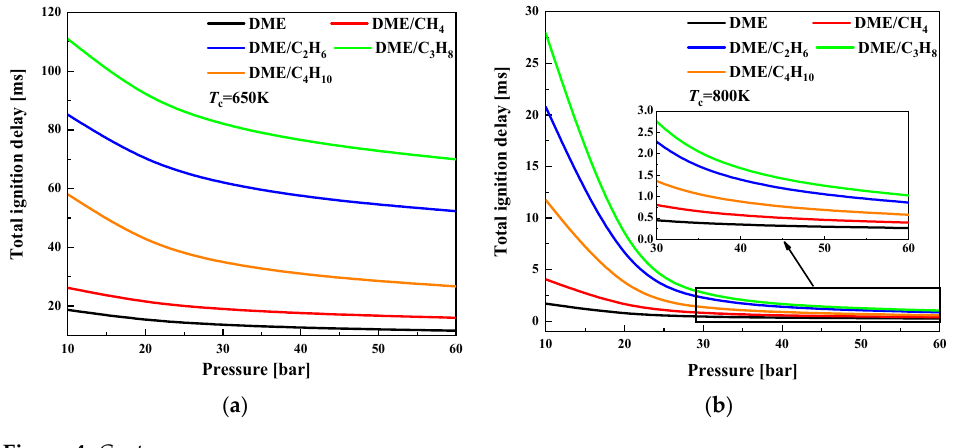
( c ) Figure 4. Ignition delay as a function of compressed pressures for various compressed temperatures at φ = 0.5: ( a ) T c = 650 K; ( b ) T c = 800 K; and ( c ) T c = 1500 K. 3.1.3. Mole Fraction Analysis To clarify the interaction mechanism between DME and C1-C4 alkane during the ig- nition process, the mole fraction of certain important species is performed at P c = 20 bar, φ = 0.5, and T c = 650, 800, and 1500 K. Moreover, the free radicals such as H, O, OH, HO 2 , H 2 O 2 , R, and RO 2 play an important role during the ignition process; thus, these free rad- icals are used to represent the ignition chemistry of the mixtures. In order to better compare the mole fraction profile of DME/C1-C4 alkane mixtures, it is essential to use the log-log coordinate in Figures 5–7. Figure 5 show the mole fraction as a function of time at P c = 20 bar, φ = 0.5, and T c = 650 K. As presented in Figure 5, the addition of C1-C4 alkane to DME will decrease the mole fraction of H, O, OH, HO 2 , R, and RO 2 radicals and delay the time corresponding to the mole fraction peak. In the DME blended with C1-C4 alkane mixtures, the mole fraction of H, O, OH, HO 2 , R, and RO 2 radicals follows the order DME/CH 4 > DME/C 4 H 10 > DME/C 2 H 6 > DME/C 3 H 8 and the time corresponding to the mole fraction peak increases in the order DME/CH 4 < DME/C 4 H 10 < DME/C 2 H 6 < DME/C 3 H 8 . Consequently, the ignition delay increases in the order DME/CH 4 < DME/C 4 H 10 < DME/C 2 H 6 < DME/C 3 H 8 .